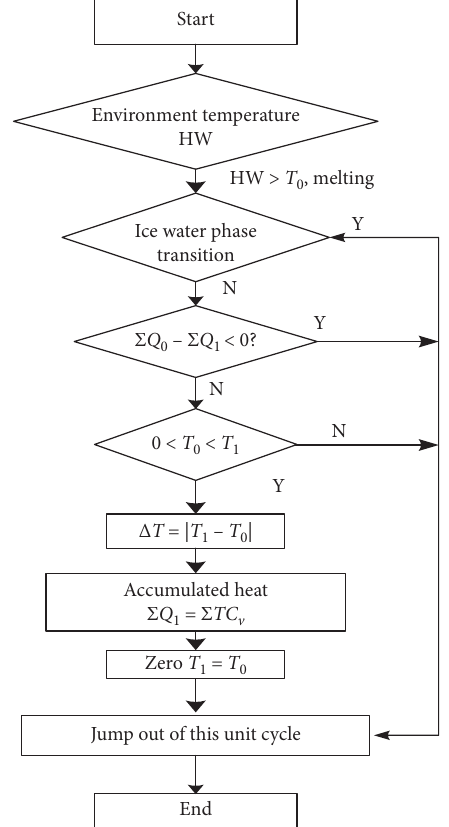
Figure 1: The simplified flow chart of ice-water phase